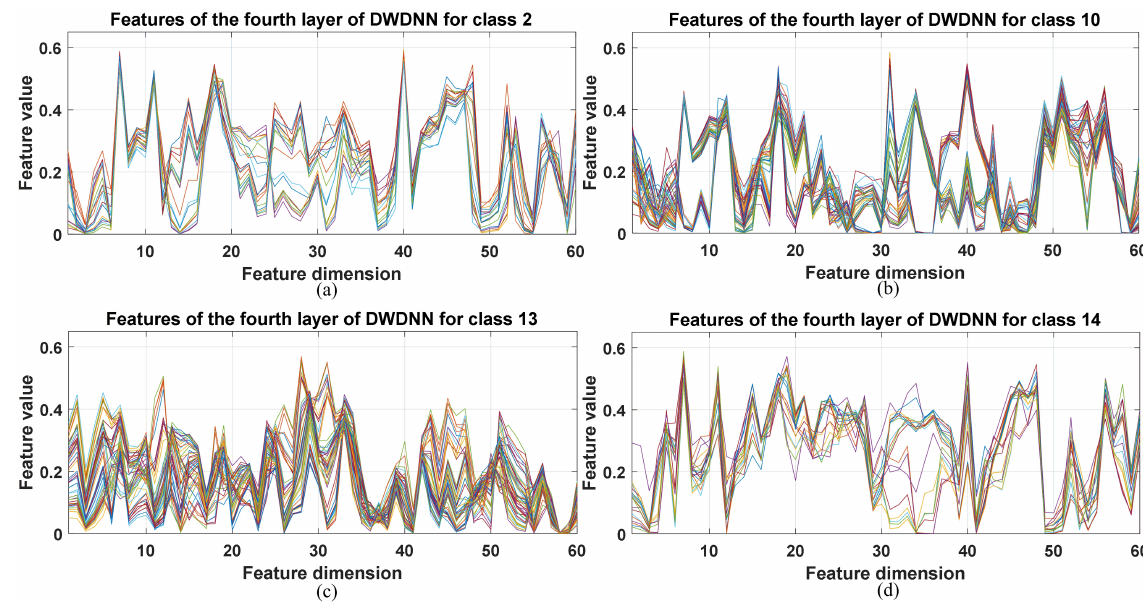
Figure 8. Stacked extracted features of the training instances from the last transform kernel layers of the DWDNN (10 EWSWS networks) with the Botswana dataset. ( a ) Extracted features for class 2. ( b ) Extracted features for class 10. ( c ) Extracted features for class 13. ( d ) Extracted features for class 14.